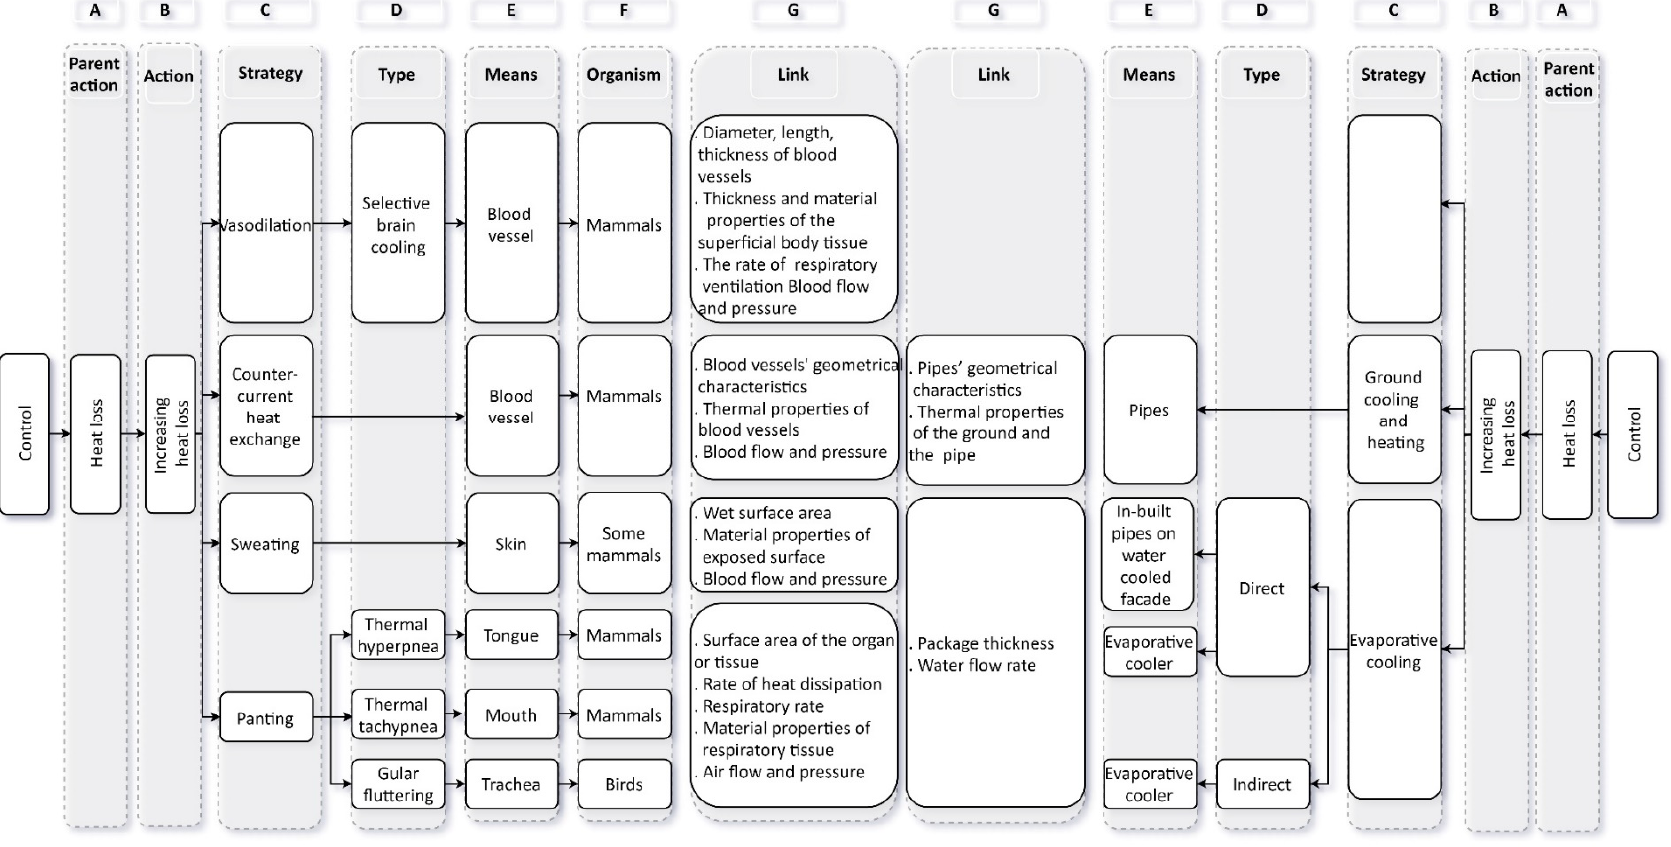
Figure 1. Section of the Thermo-bio-architectural Framework (ThBA) (part of the focus group materials) related to active strategies for animals.